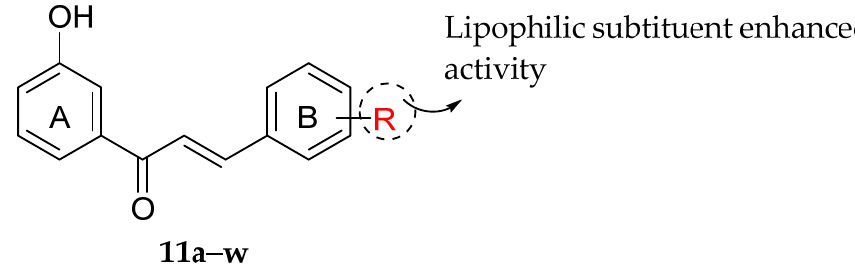
Figure 29. Important feature for chalcone containing non-polar groups to exhibit antibacterial activity against B. bronchiseptica [98].